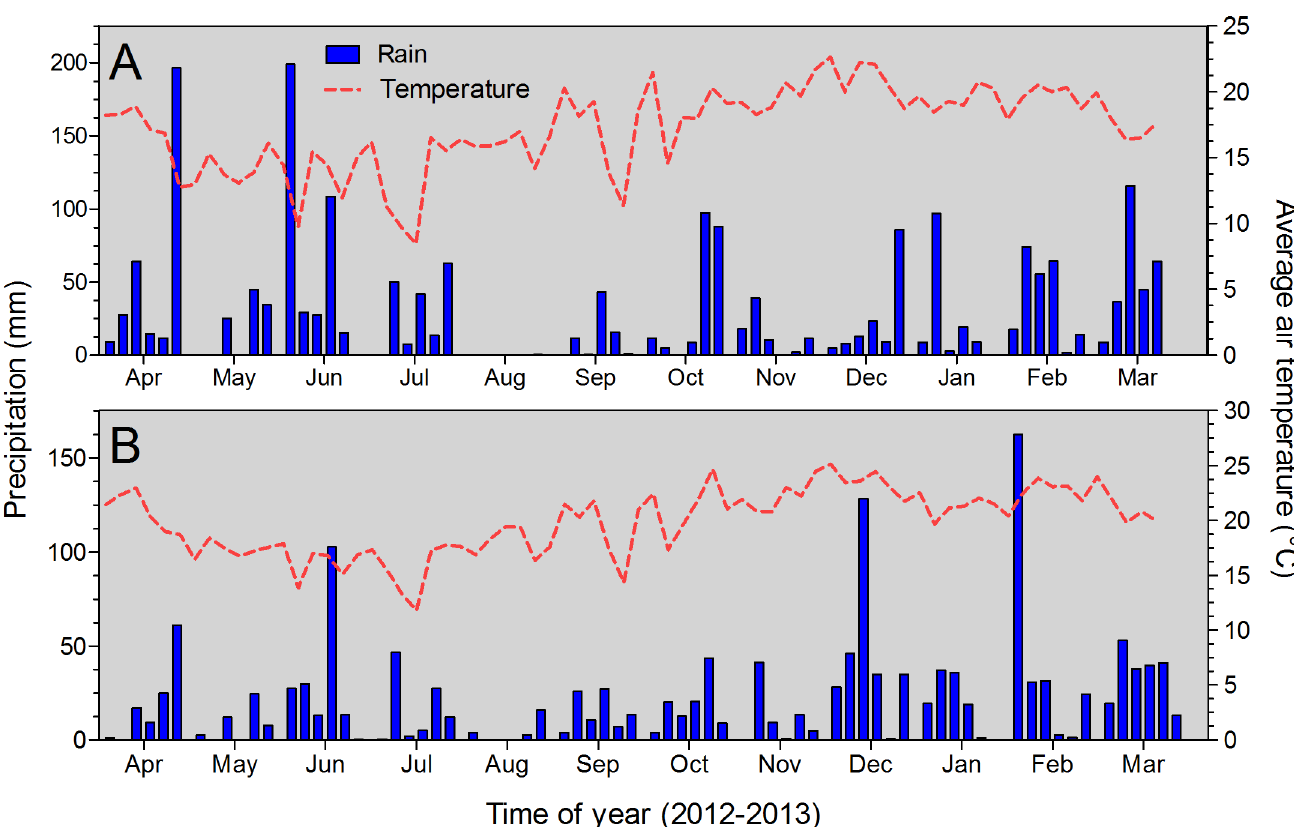
Fig 1. Seasonal precipitation and average air temperature during study period, from April 2012 to March 2013. (A) for site I, Guarapuava and (B) for site II, Taquarituba both located in Brazil. Blue bars referred to the precipitation, and red dashed lines represent the average seasonal